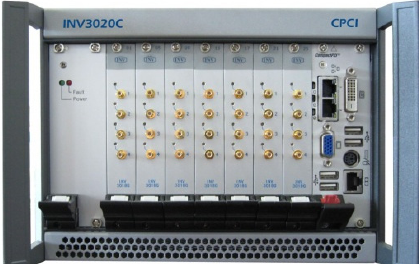
Figure 3. The sampling system.